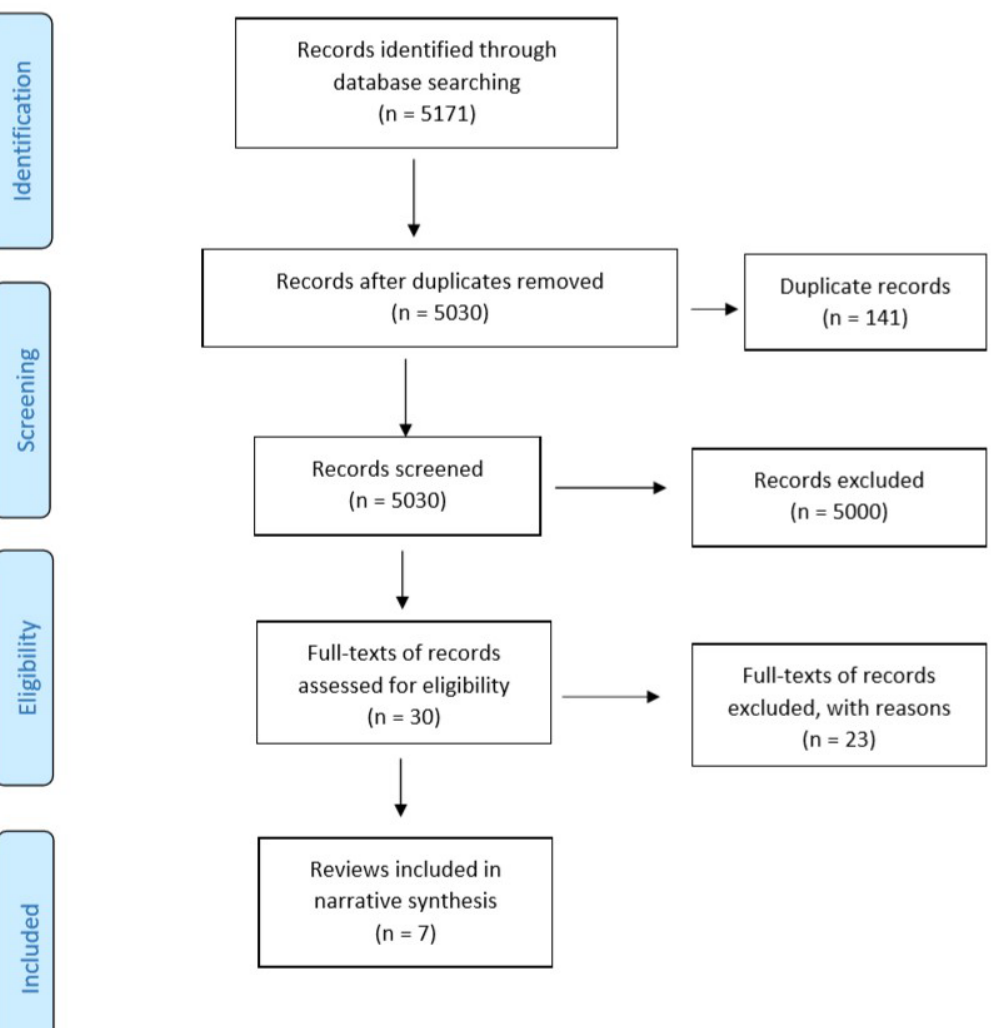
Figure 1. PRISMA study flow diagram. Search conducted from database/s inception up until March